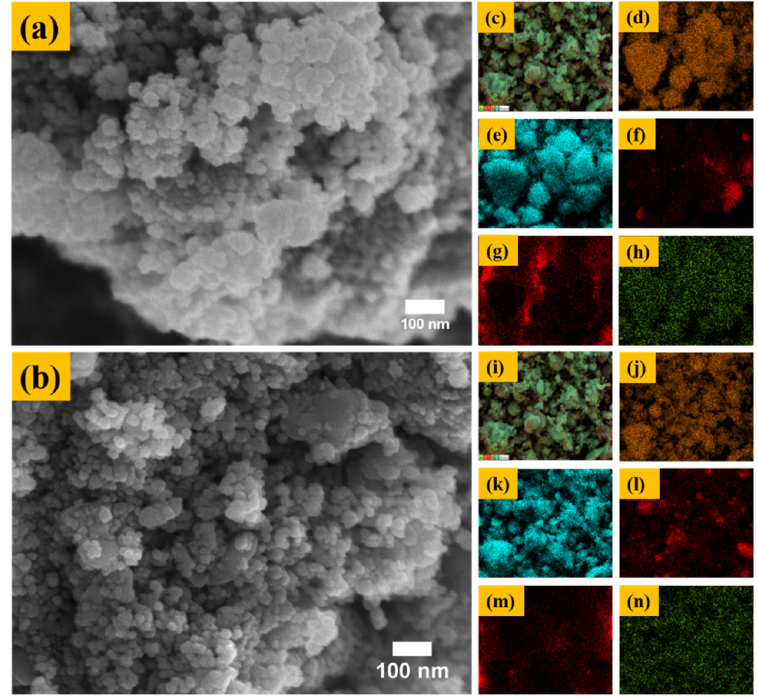
Figure 2. FE-SEM micrographs of ( a ) FNN-221 sample and the left side image ( b ) SEM image of FNN-211 compound, ( c – n ) corresponding EDX mapping of the site indicating the distribution of Au, C, Fe, O, Ni elements, respectively, for both the samples.